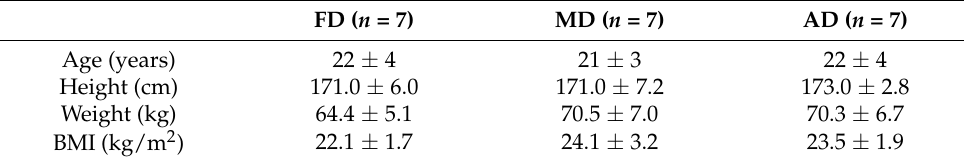
Table 1. Characteristics of female handball players (mean and standard